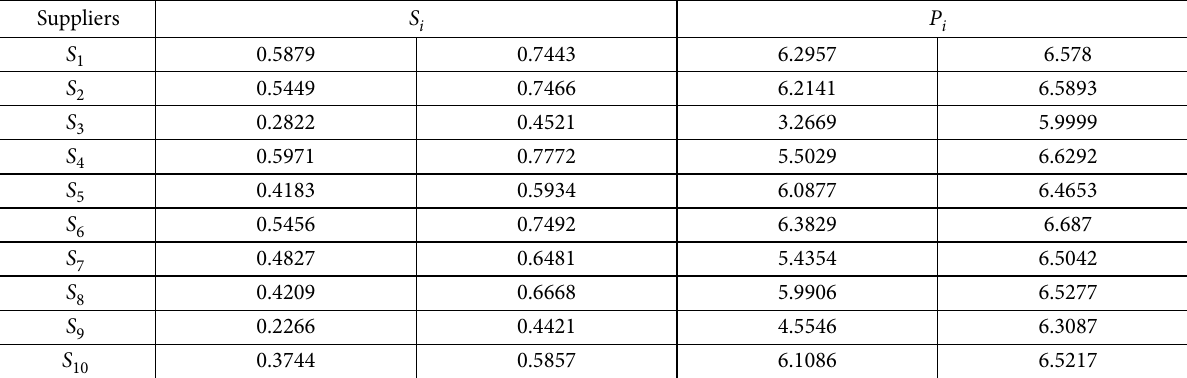
Table 13. The computed values for S i and P i per supplier